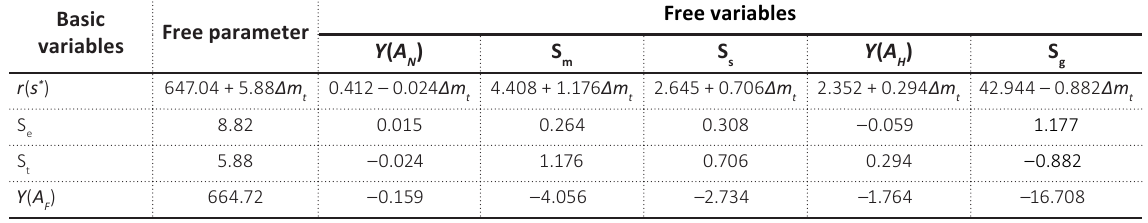
Table A3. Price variability for traditional recreation services (destination of nature-based “wow-effect” tourism)